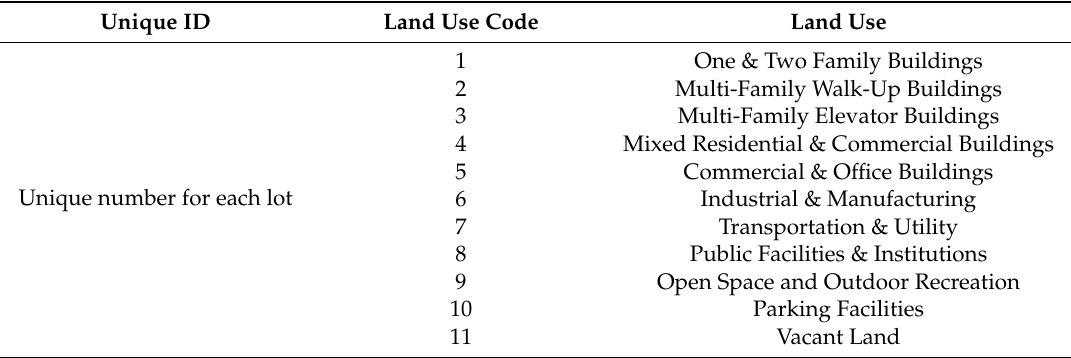
Table 1. Geo-spatial dataset about land